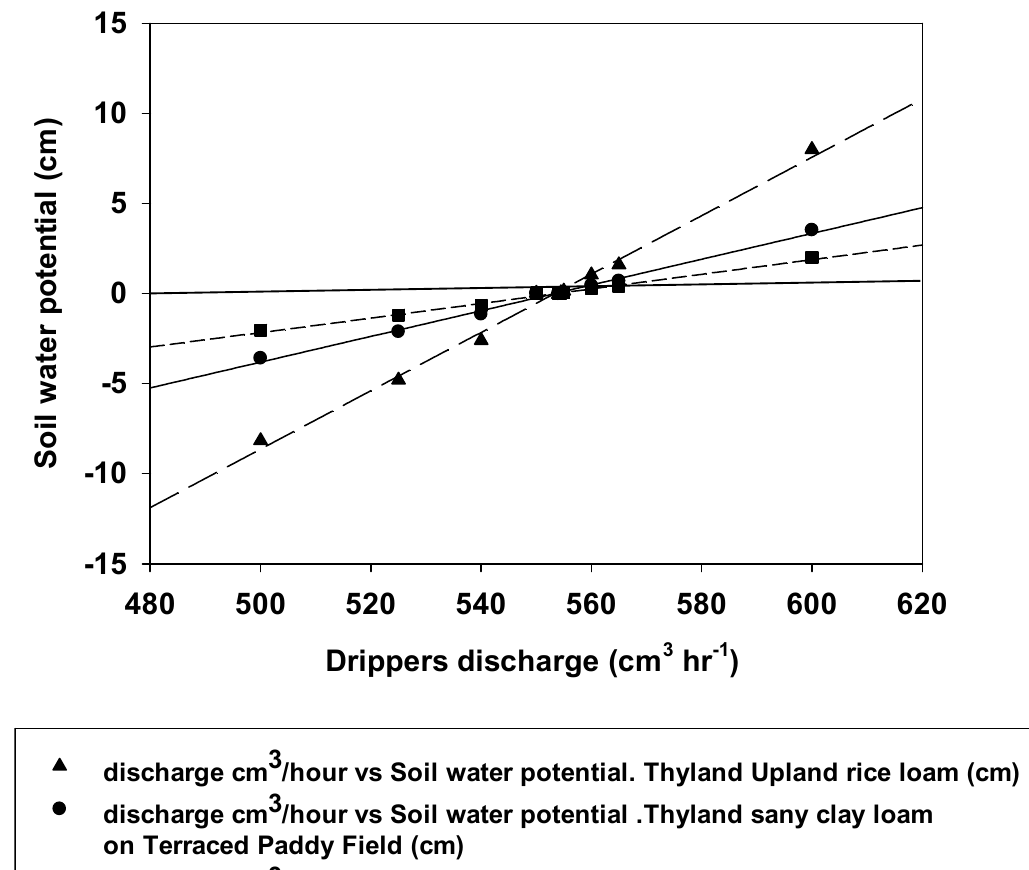
Figure 8. The correlation between the soil water potentials of three different soils. Data for the first two soils were collected from Noppol et al. [22] on cultivated soils. The solid line marks the zero soil water potential.